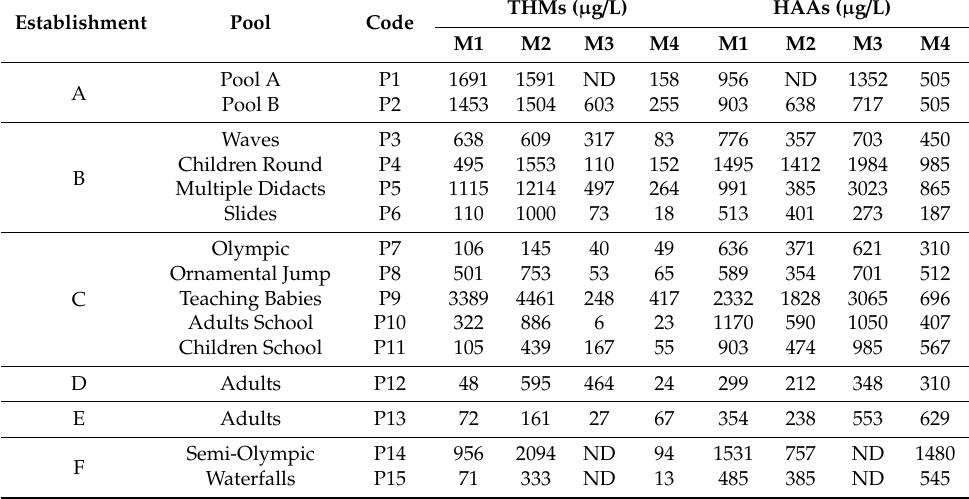
Table 1. Results of trihalomethanes (THMs) and halogenated acetic acids (HAAs) concentration